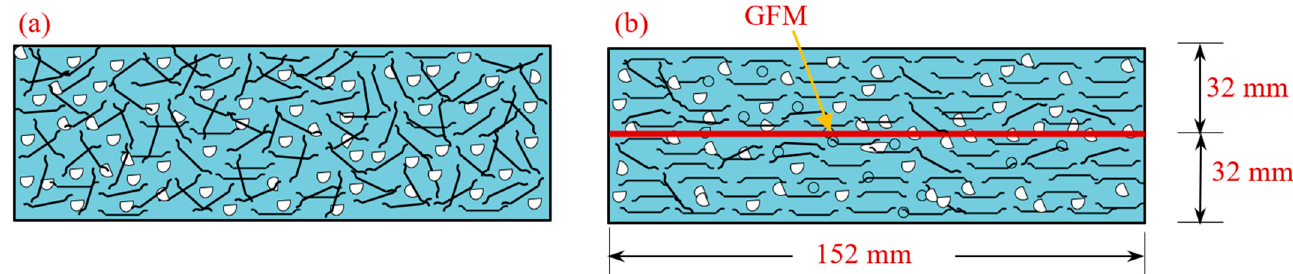
Figure 16. Comparison of fiber orientation, ( a ) 3D orientation in FC, ( b ) Planar orienatation in FG2-150.